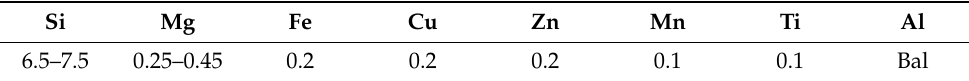
Table 1. Typical composition of the A356 ally used in the current